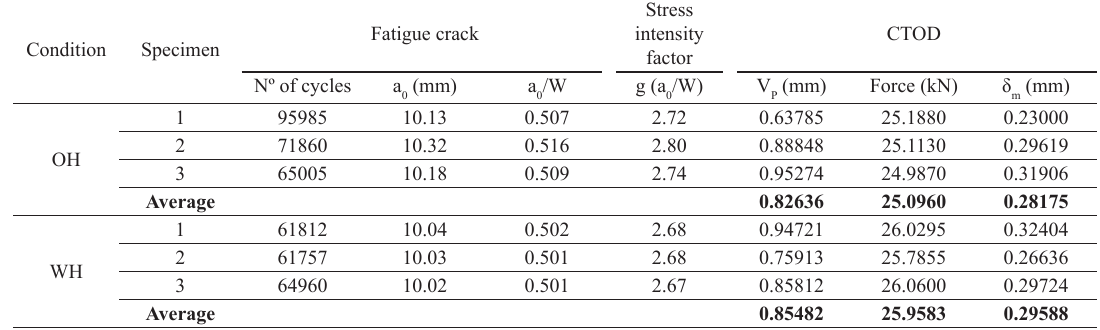
Table 12. Results of CTOD tests of the base metal, ASTM A182 F22 steel, without (OH) and with (WH) hydrogenation.